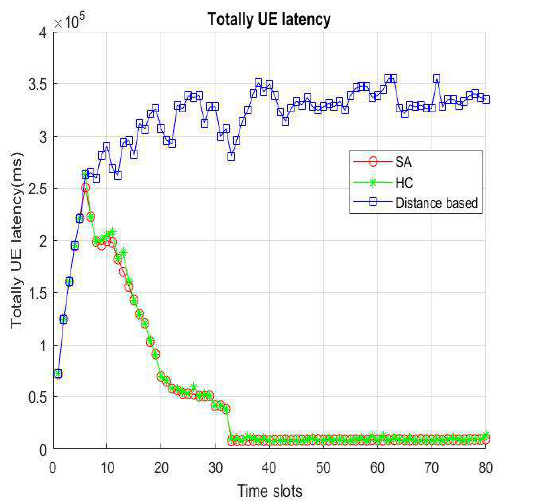
Figure 12. Total latency per time slot.